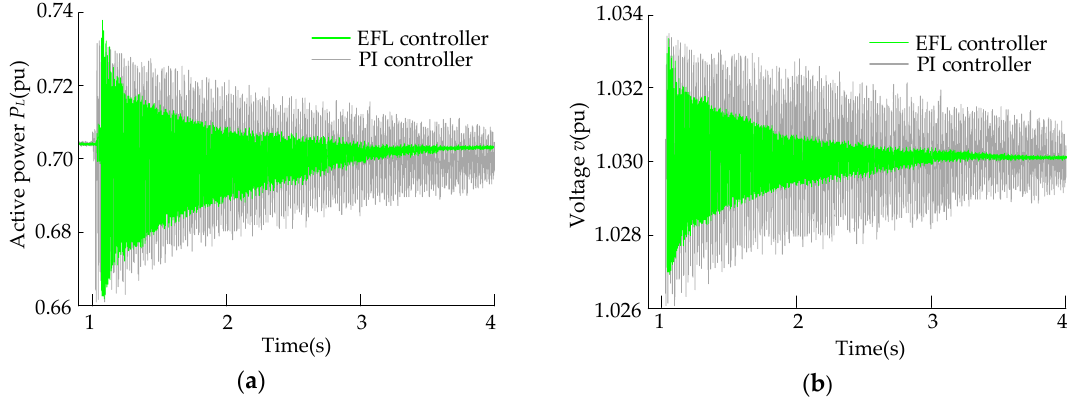
Figure 6. System responses at a wind speed of 8 m/s and a series-compensation of 70%: ( a ) transmission line active power; ( b ) point of common coupling (PCC) voltage.